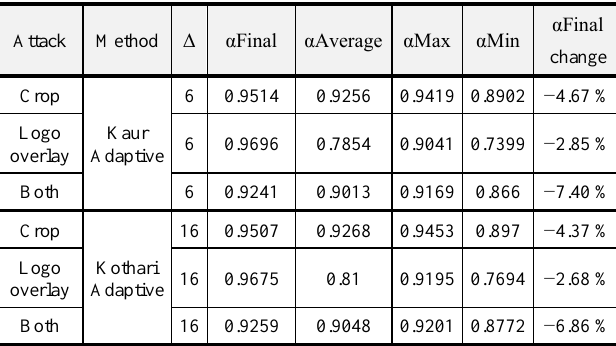
R ESULTS AFTER G EOMETRICAL A